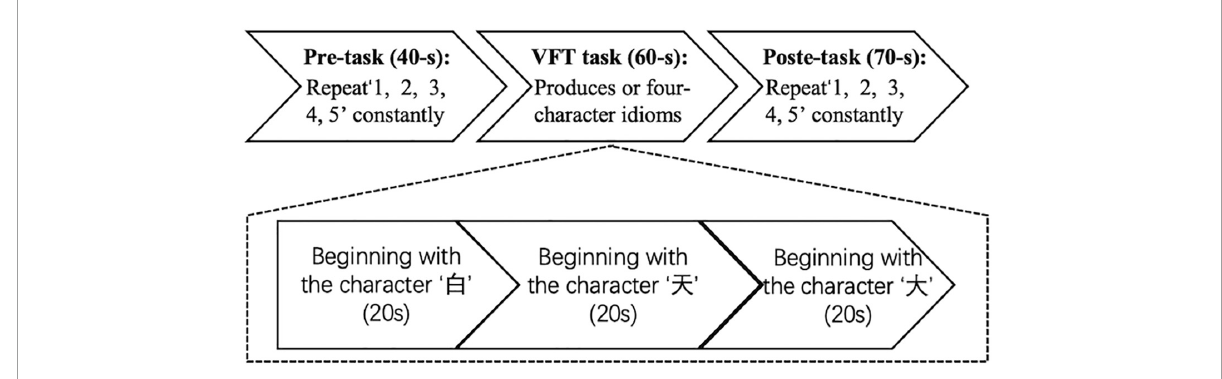
FIGURE2 Experimental flowchart. The experiment has three procedures: 40-s pre-task, 60-s verbal fluency task (VFT) task, and 70-s